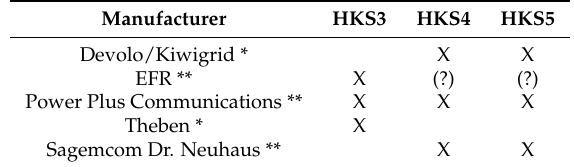
Table 3. HAN communication scenarios (“HAN-Kommunikationsszenario”, HKS) implemented by SMGW manufactures. No statement was acquired from EMH metering, Discovergy, and Landys + Gyr. Manufacturer HKS3 HKS4 HKS5 Devolo/Kiwigrid